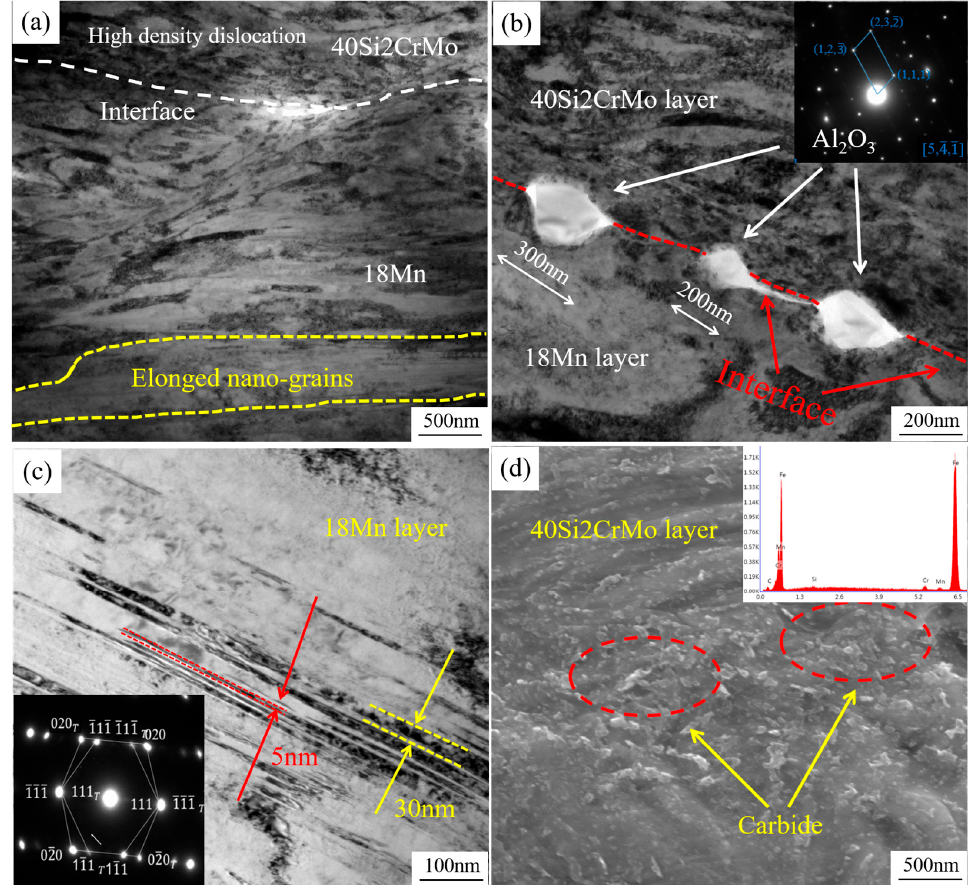
Figure 5. TEM and SEM images of 18Mn/40Si2CrMo multilayer composite steel plate at 500 °C: ( a , b ) interface; ( c ) the 18Mn layer; ( d ) the SEM image of 40Si2CrMo